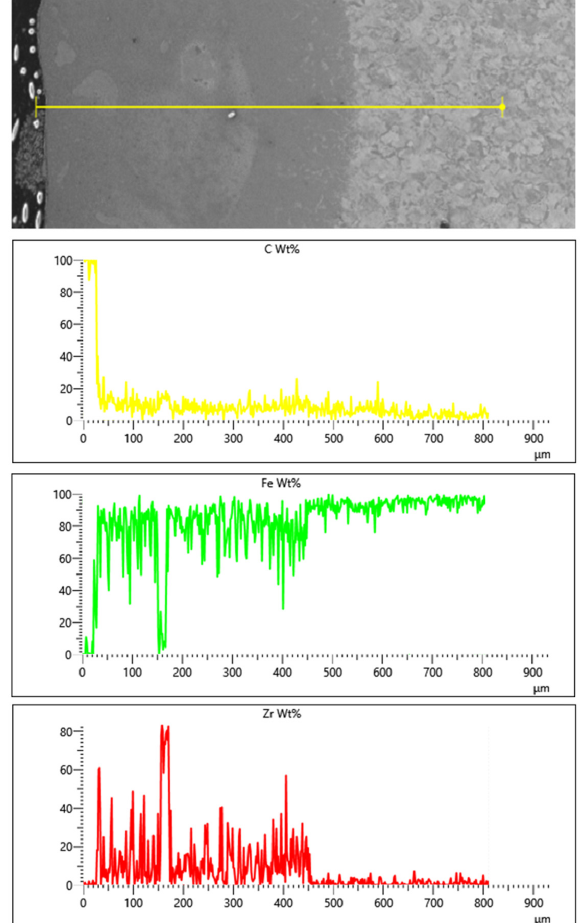
Figure 15. Linear EDS analysis on cross section of Fe/ZrC coating produced using laser beam power 1100 W .